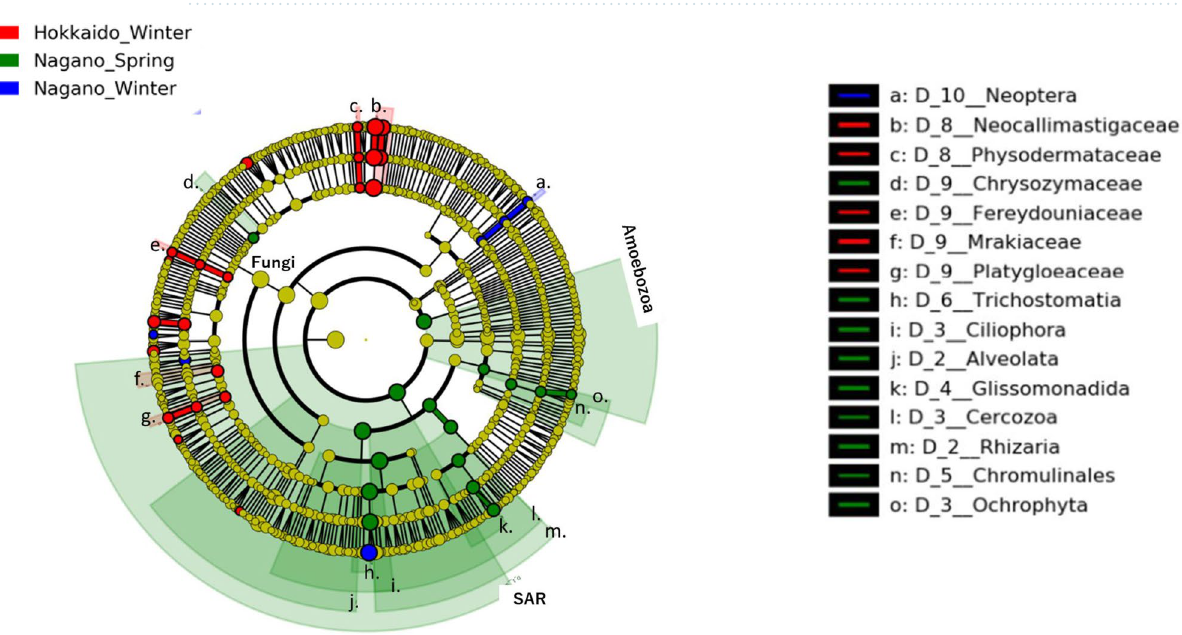
Figure 7. Cladograms of bacterial taxa in ruminal bacterial composition detected by the LEfSe approach. Red, green, and blue indicate significantly different groups (Hokkaido winter, Nagano spring, and Nagano winter, respectively), with the diagram and species classification at the phylum, class, order, family, and genus levels shown from the inside to the outside. Yellow circles represent species with no significant difference. Letters in the cladograms indicate the significantly different taxa in each clade including more than 2 taxa.